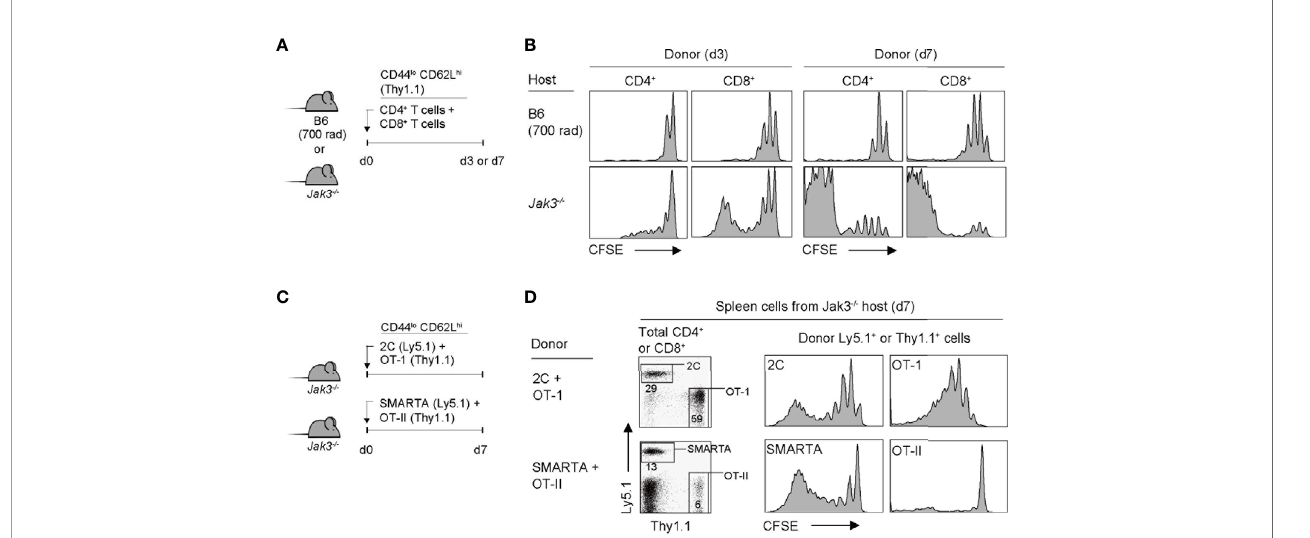
FIGURE 1 | Robust proliferation of naive T cells adoptively transferred into Jak3 − / − mice. (A) Schematic diagram for adoptive transfer experiments. A mixture of CFSE-labeled naive CD4 + and CD8 + T cells puri fi ed from B6 mice (Thy1.1) was co-injected i.v. into either irradiated (700 rad) B6 mice or unmanipulated Jak3 − / − mice (1 × 10 6 cells for each donor per mouse; n = 3 – 5 mice). (B) Spleen cells of the recipient mice were analyzed on days 3 and 7 for CFSE dilution by fl ow cytometry. (C) Schematic diagram for adoptive transfer experiments. A mixture of FACS-puri fi ed CFSE-labeled either naive 2C (Ly5.1) and OT-I (Thy1.1) CD8 + or naive OT-II (Thy1.1) and SMARTA (Ly5.1) CD4 + T cells was co-injected i.v. into Jak3 − / − mice (0.5 – 1 × 10 6 cells for each donor per mouse; n = 2 – 3 mice). (D) Spleen cells of the recipient mice were analyzed on day 7 for CFSE dilution by fl ow